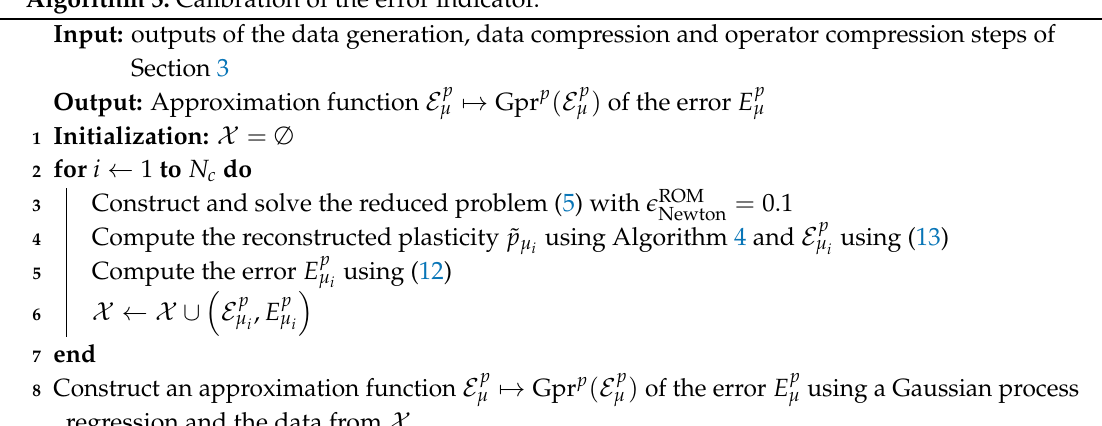
Algorithm 5: Calibration of the error